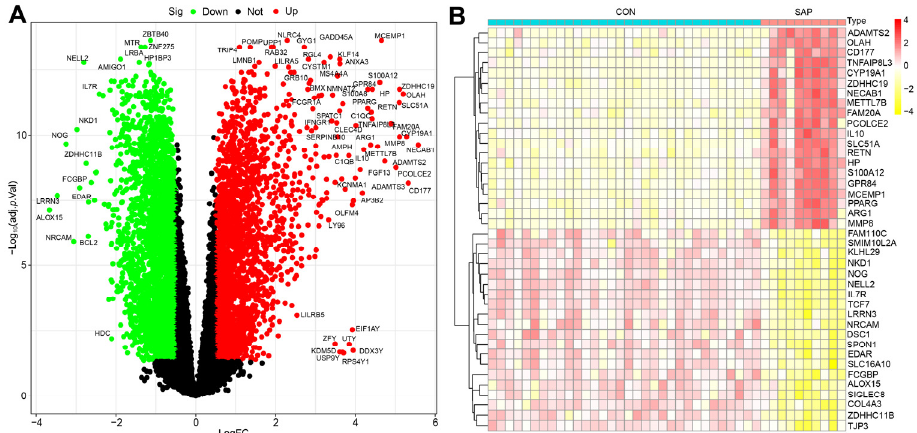
Figure 1. Volcano plot showing DEGs in SAP patients versus healthy controls ( A ) and the heatmap of TOP20 differential genes (upregulated and downregulated, ( B )).